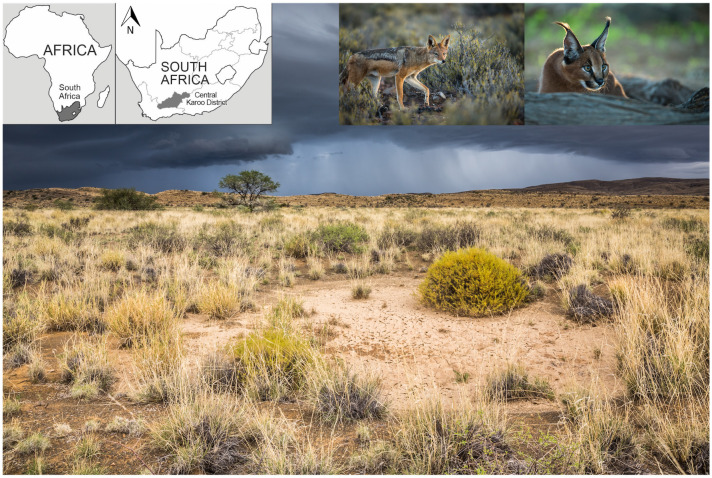
Study site and study species.Top left: Maps of South Africa and the Central Karoo District within South Africa, where the study took place. Top right: Pictures of black-backed jackal and caracal in the Karoo. Background picture: Typical landscape of an extensive small-livestock farm in the Central Karoo District, South Africa. Photography © Houdin & Palanque.